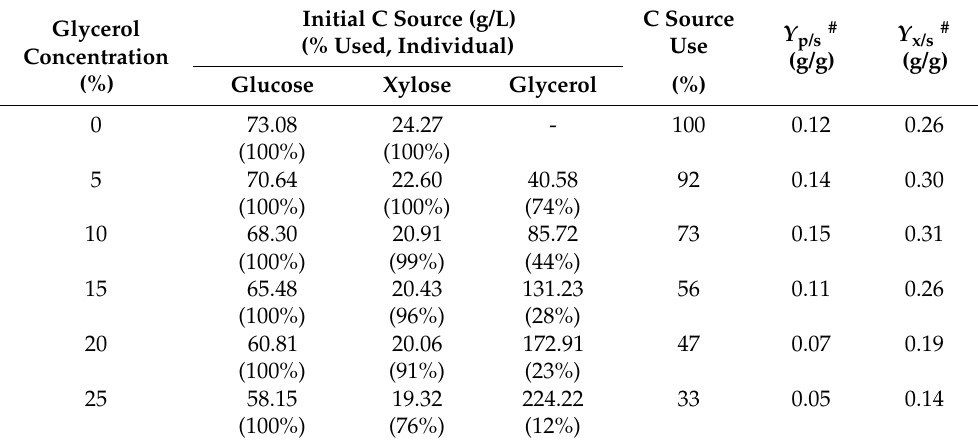
C Source Y p/s # Y x/s # Use (g/g) (g/g)